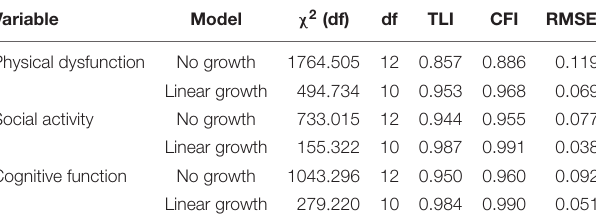
TABLE 3 | Comparisons of fitted growth curve models for the